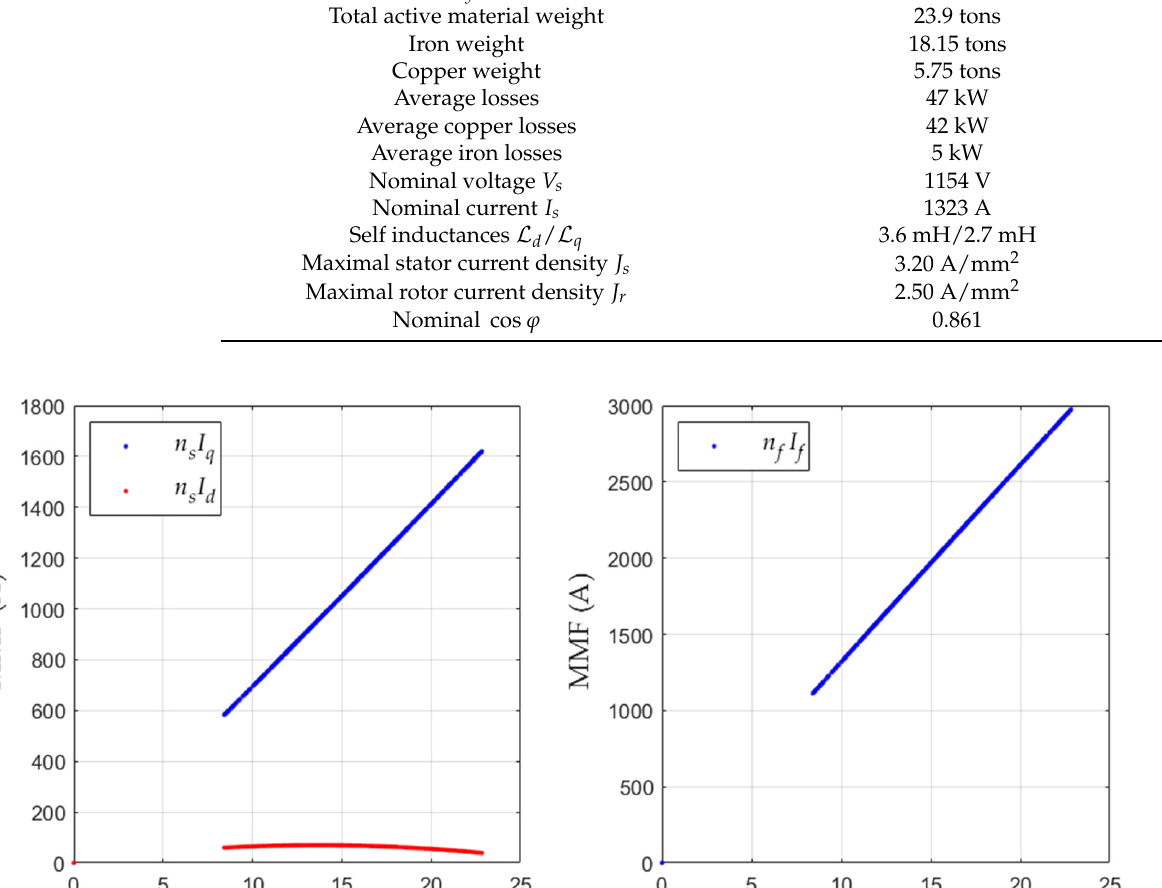
Generator Parameter